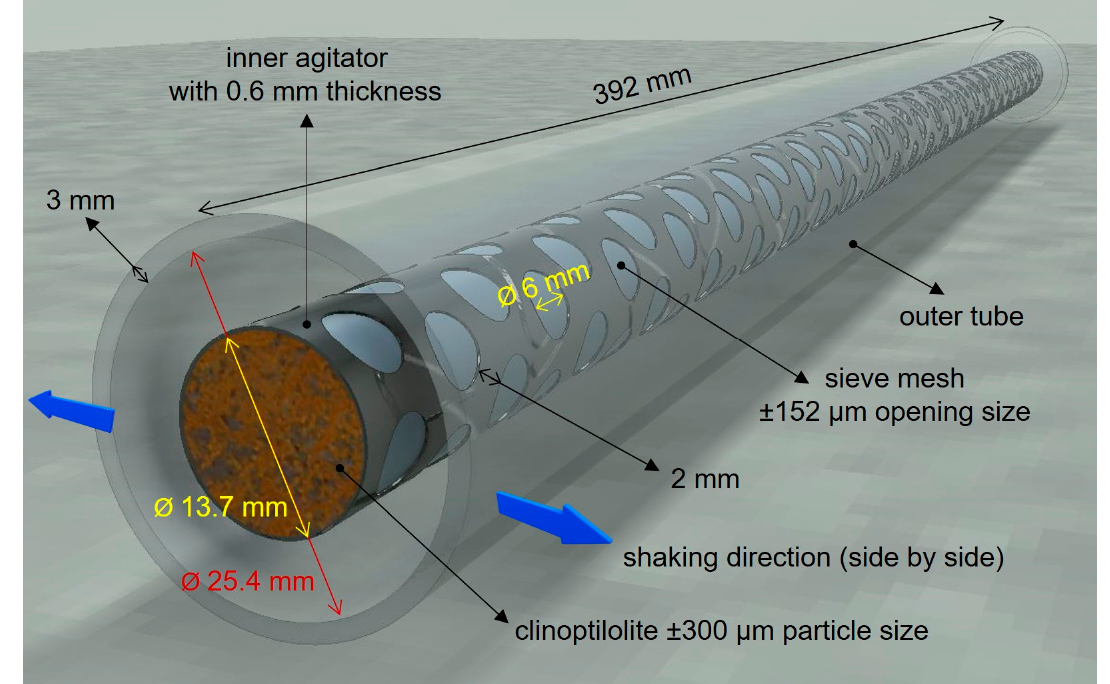
Figure 2. Rendered image highlighting the motion of the inner agitator and outer tube of the ATR.